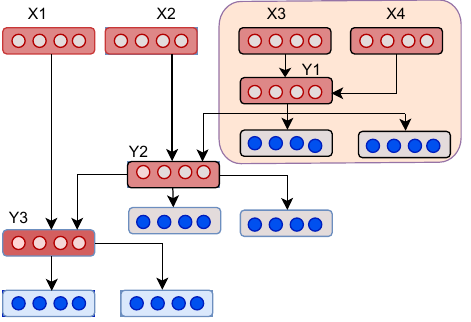
(cid:16) W ( 1 ) [ X 3 ; X 4 ] + b